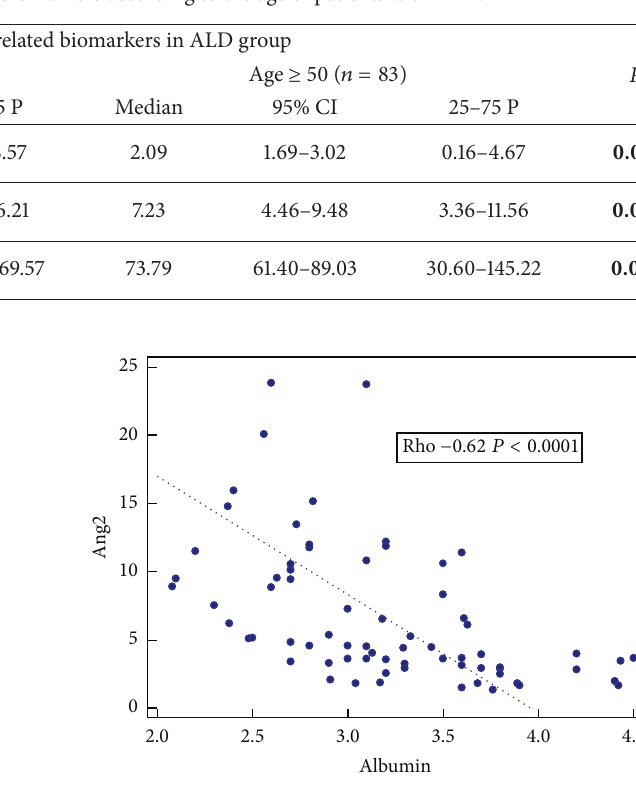
Figure 1: Correlation between Ang2 concentrations (ng/mL) and INR.